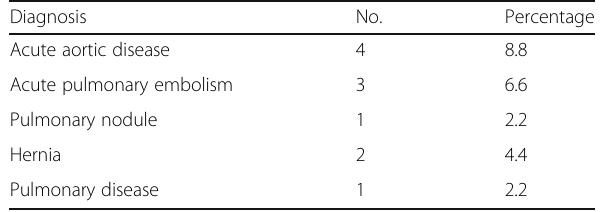
Table 5 Number of patients with non-coronary positive